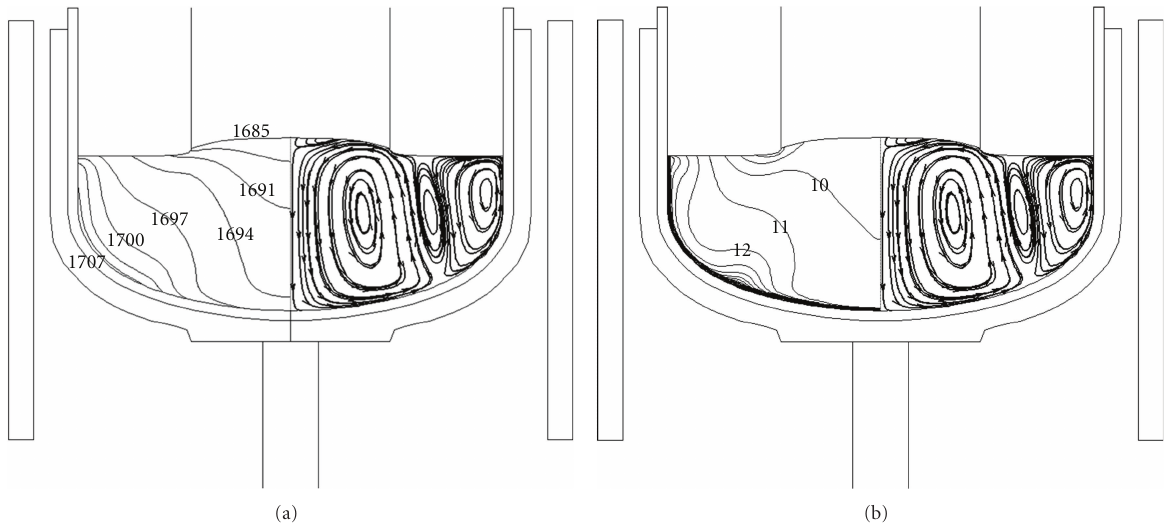
Figure 6: Distribution of temperature, streamtrace, and oxygen concentration in the melt for L = 300 mm in a conventional CZ furnace ( h = 50 mm): (a) isothermal lines (left) and streamtraces (right); (b) oxygen concentration isolines (left) and streamtraces (right). The units of temperature, velocity vector, and oxygen concentration are K, m/s, and ppma, respectively. The spacing of the isothermal lines and concentration isolines are 3 K and 1ppma,